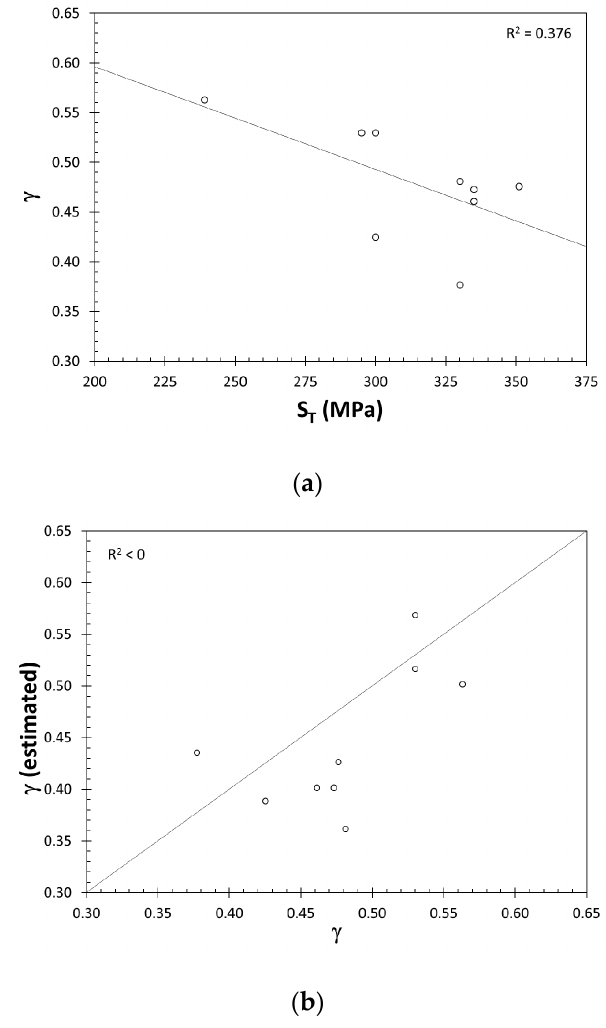
Figure 3. ( a ) The relationship between γ and S T , as suggested by Dowling et al. [9], and ( b ) the comparison of Walker parameters for best fit and estimated by using the equation proposed by Lv et al. [8].